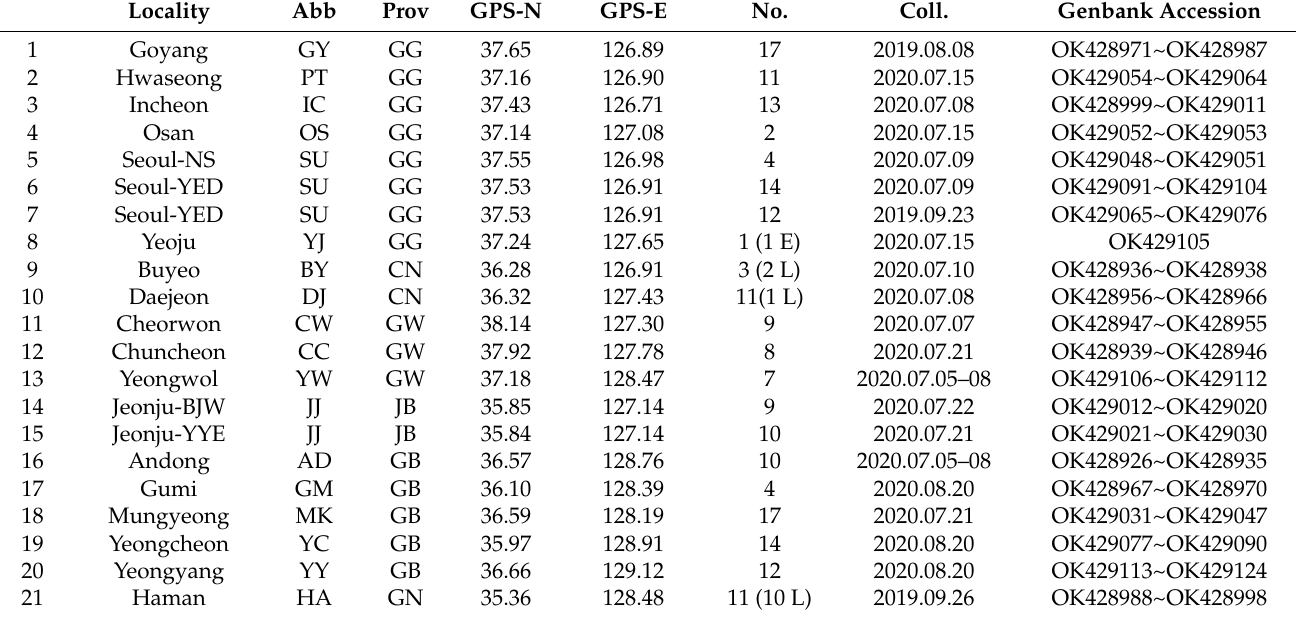
Table 1. RLB samples included in this study. Collected locality, abbreviation (Abb), province (Prov.), GPS data, number of samples used in genetic analyses (No.), larvae (L), egg (E), collection date (Coll.), and Genbank accession numbers.